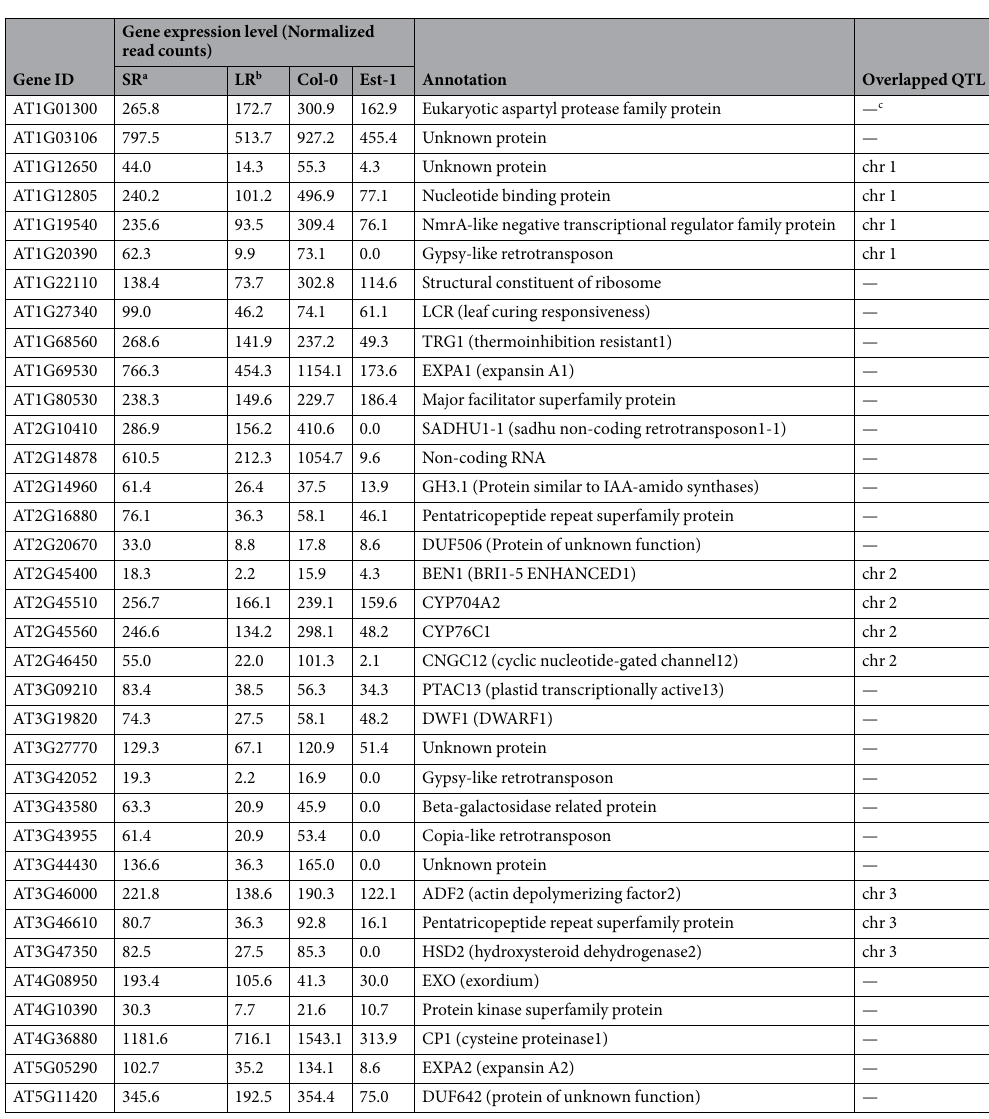
Table 2. Genes highly expressed in primed seeds of short longevity genotypes (bulked-short RILs and Col-0). a SR; bulked-short RILs. b LR; bulked-long RILs. c No overlap with the